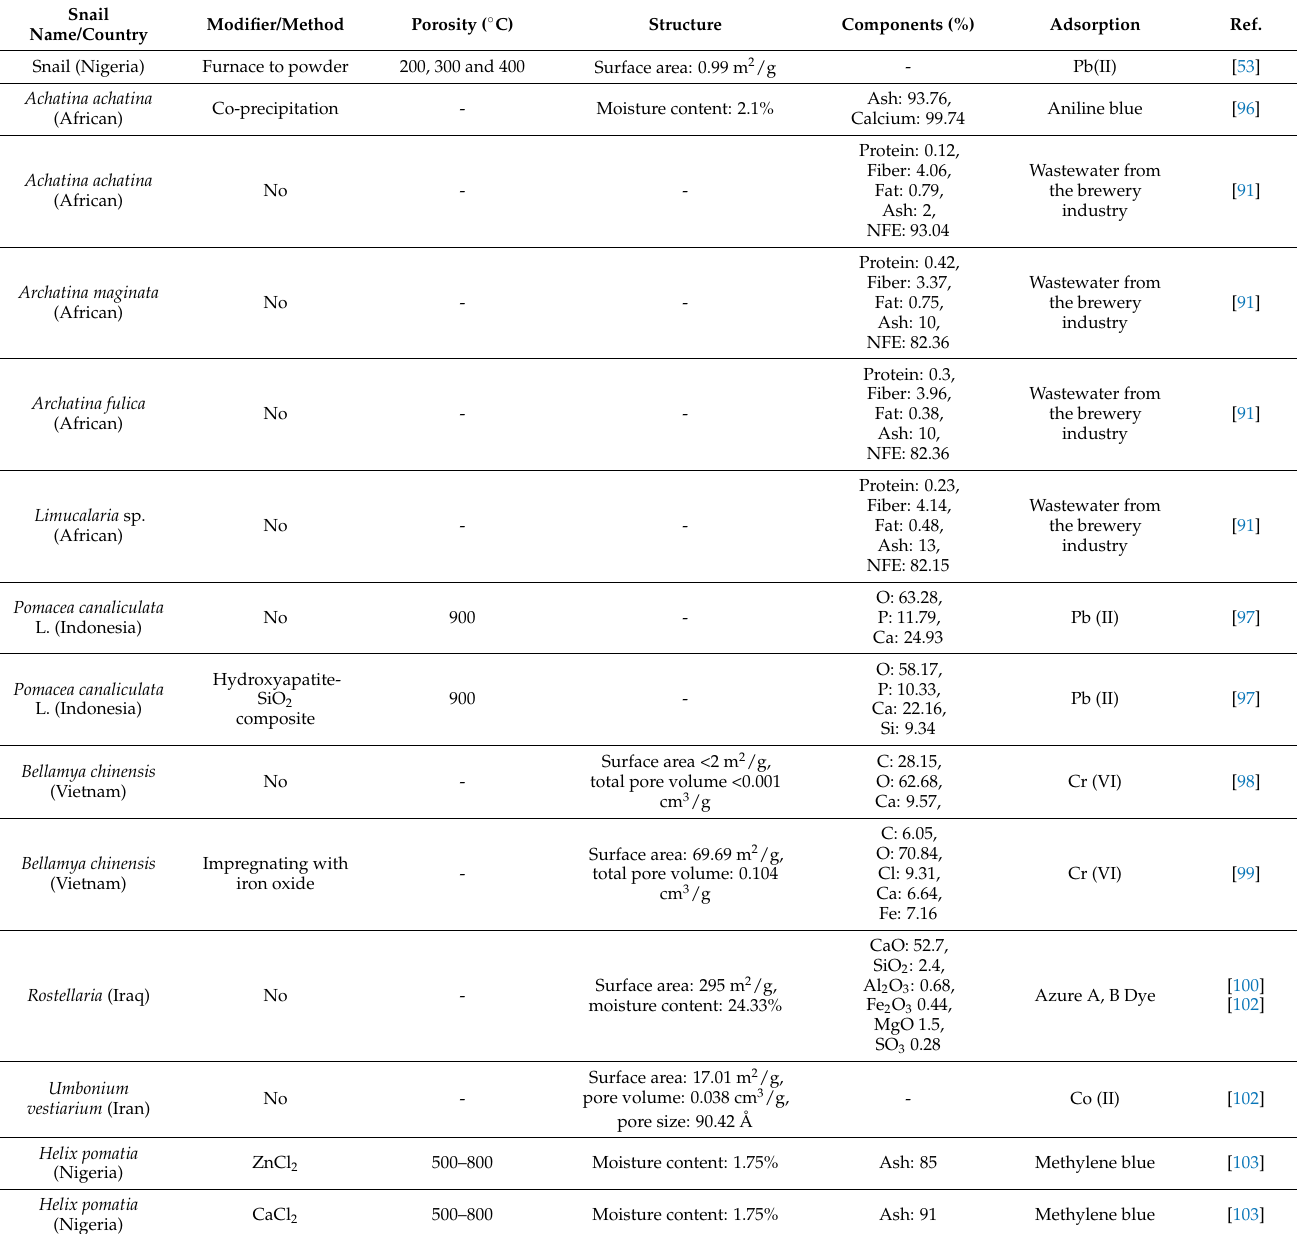
Table 2. Snail shell material structure for absorbing different types of